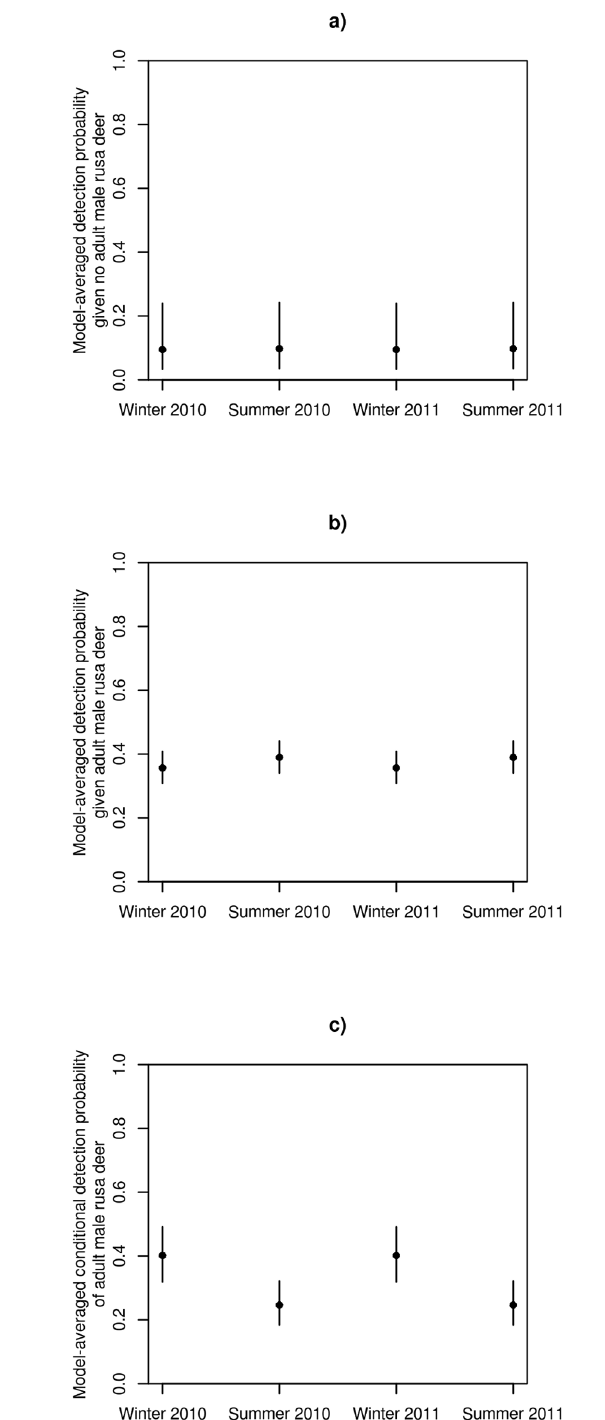
Fig 5. Model-averaged detection probabilities of rusa deer. The model-averaged detection probabilities of rusa deer at locations without adult male rusa deer ( a ), of rusa deer at locations with adult male rusa deer ( b ), and the conditional detection probability of adult male rusa deer given rusa deer have been detected at locations with adult male rusa deer ( c ) in each season and year sampled. Vertical lines indicate 95% confidence